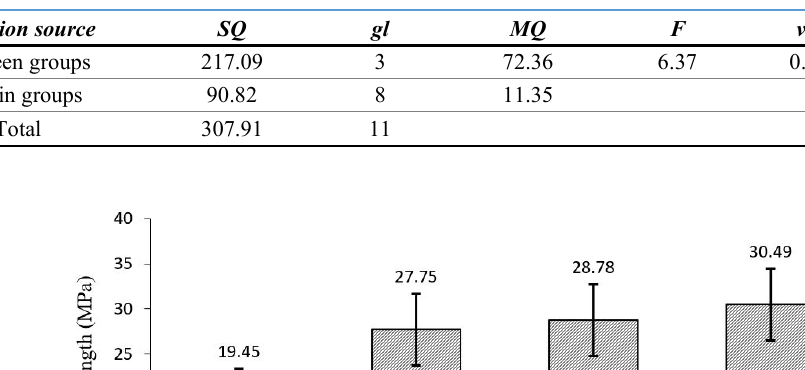
Table 8. ANOVA Phase 2 – the influence of nanosilica content in concrete tensile strength